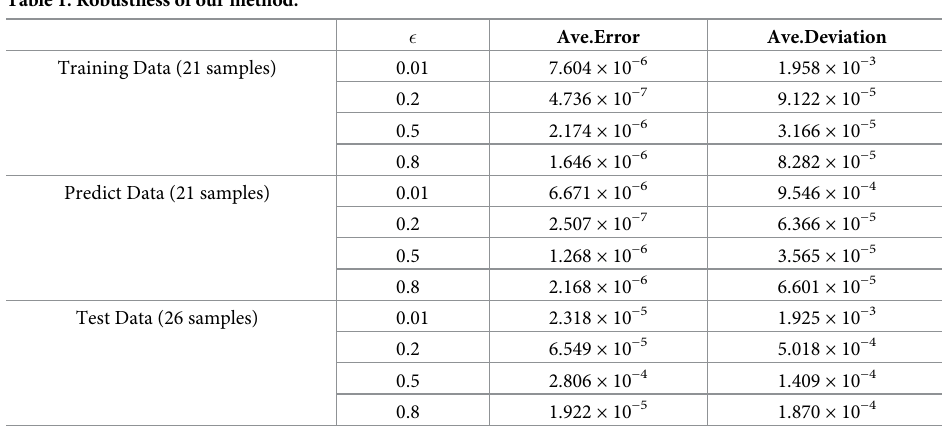
The Training Data are 21 sample points uniformly distributed in the training interval, the Predict Data are 21 sample points randomly distributed in the training interval, and the Test Data are 26 sample points uniformly distributed in the test